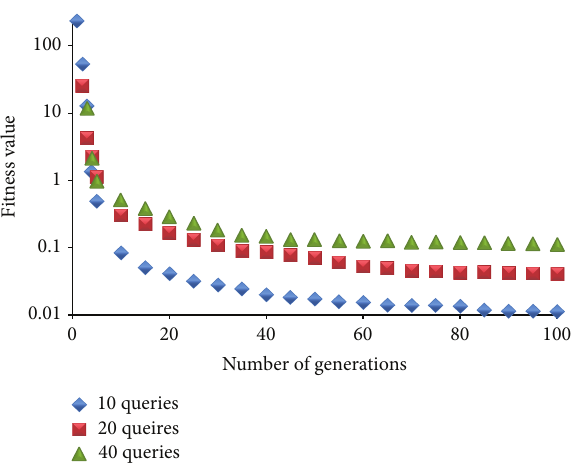
Figure 13: Average fitness values of 40 individuals and 100 genera- tions for increasing number of submitted queries.